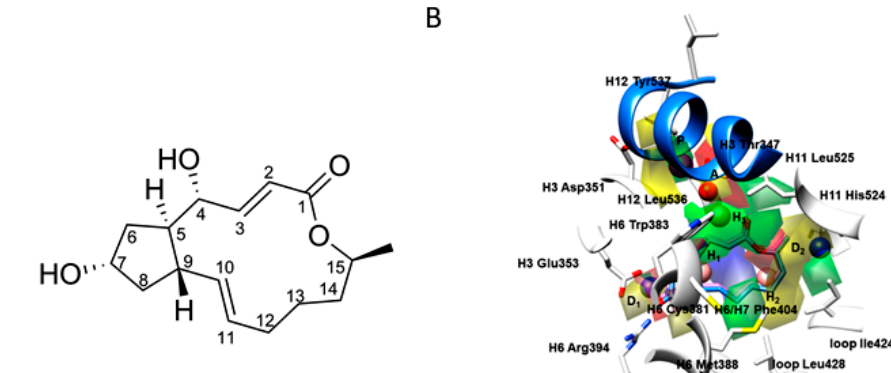
Figure 6. The NCI89671 (viz., BFA) structure and nomenclature ( A ); the SB/LB virtually screened conformations of NCI89671 , SB conformation blue, LB conformation pink ( B ).